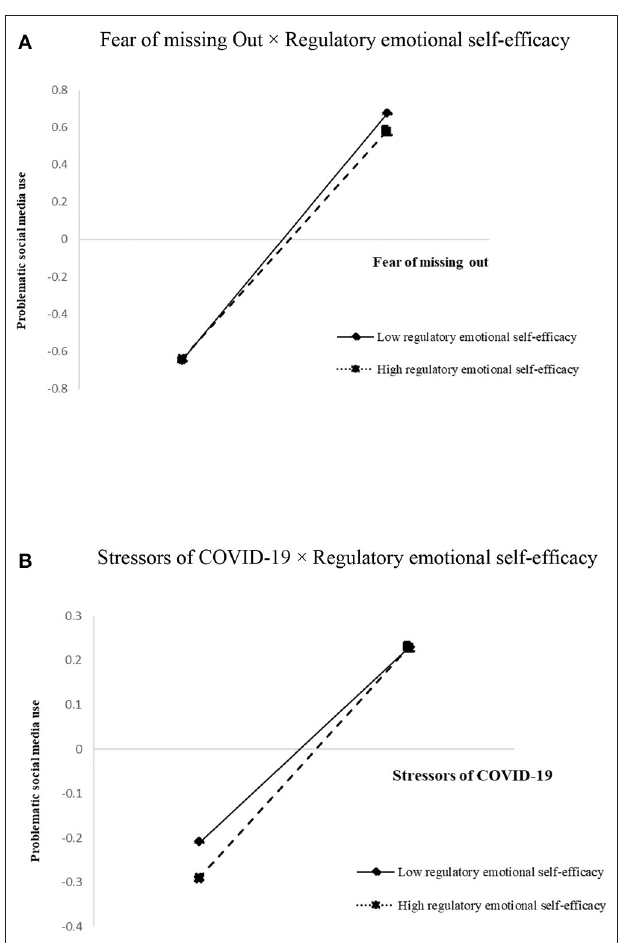
FIGURE 2 | The plot of the relationship between fear of missing out and problematic social media use at two levels of regulatory emotional self-efficacy (A) . The plot of the relationship between stressors of COVID-19 and problematic social media use at two levels of regulatory emotional self-efficacy (B) . (A) Fear of missing Out × Regulatory emotional self-efficacy. (B) Stressors of COVID-19 × Regulatory emotional